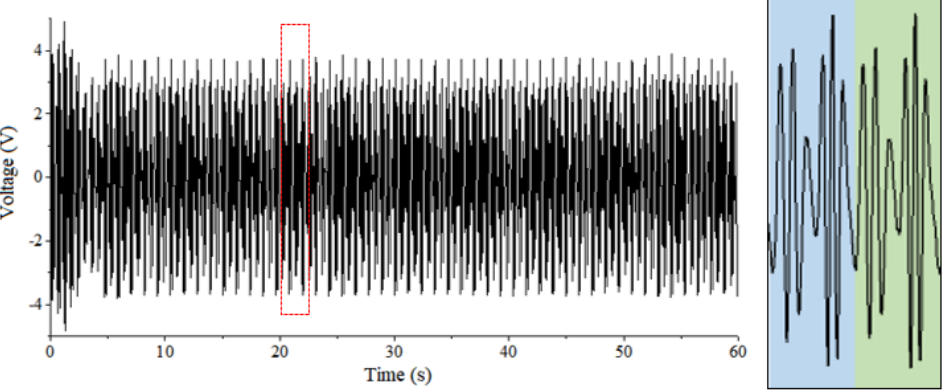
Figure 11. Voltage diagram (including the zoom-up of the enclosed region between 20.0 s and 22.4 s) under traveling waves of T / T p = 1.0, h = 0.6 m.